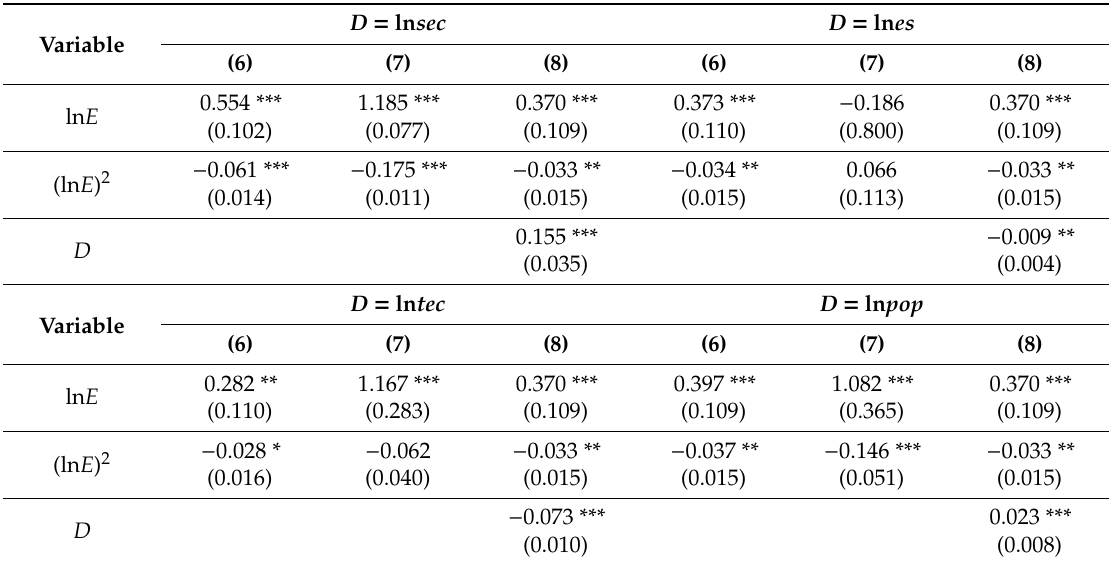
Table 9. Mediation e ff ect test.